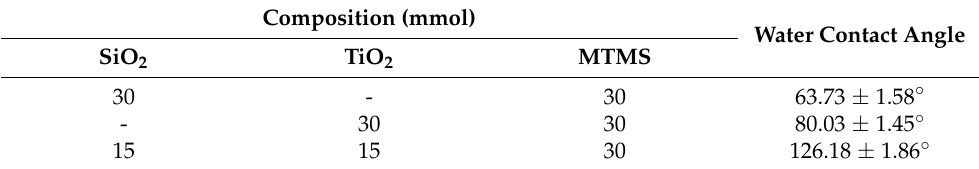
Table 3. The influence of SiO 2 , TiO 2 , and SiO 2 -TiO 2 on the hydrophobicity of coatings.